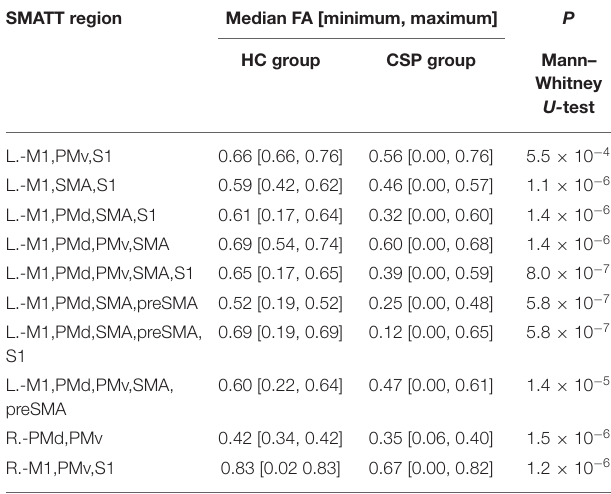
TABLE 1 | FA differences in SMATT regions between HC and CSP